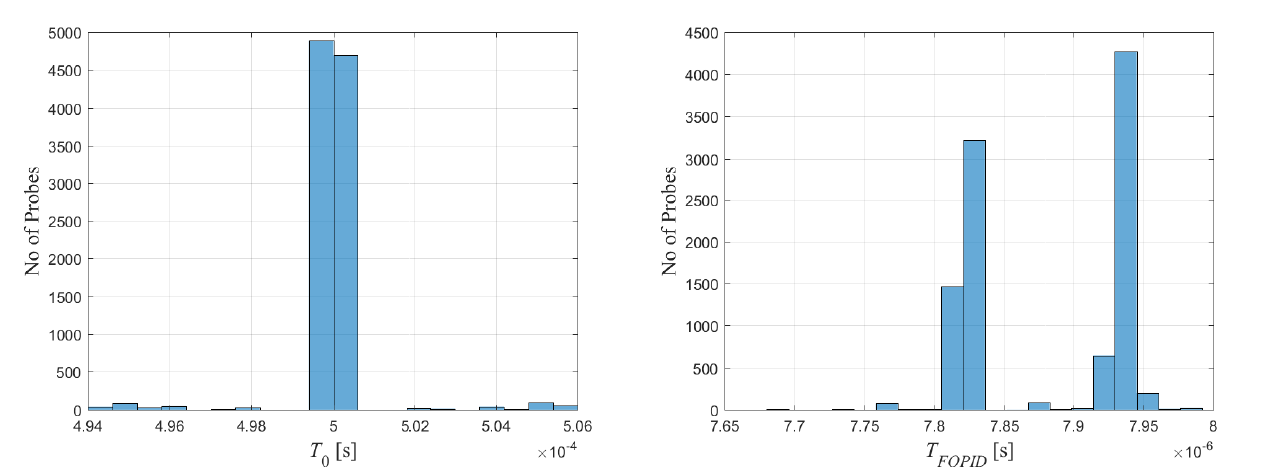
Figure 13. Duration of calculations using CFE.